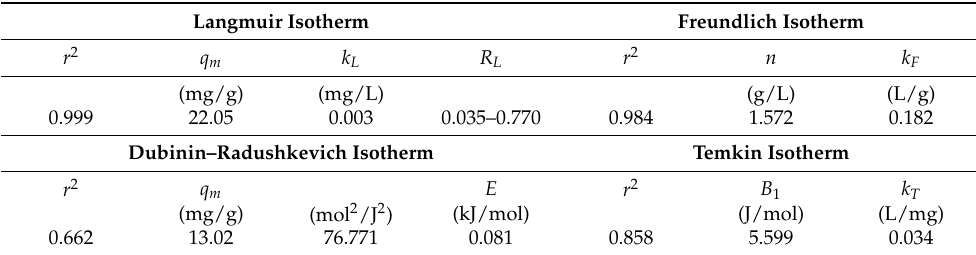
Table 5. Comparison of equilibrium parameters for Langmuir, Freundlich, Dubinin–Radushkevich and Temkin isotherms. Langmuir